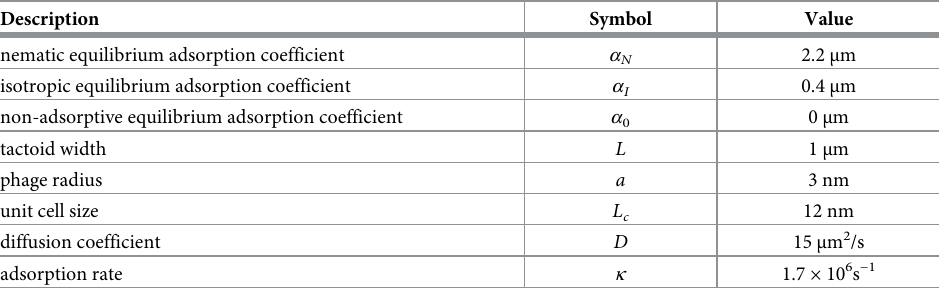
Table 1. Summary of parameter values.